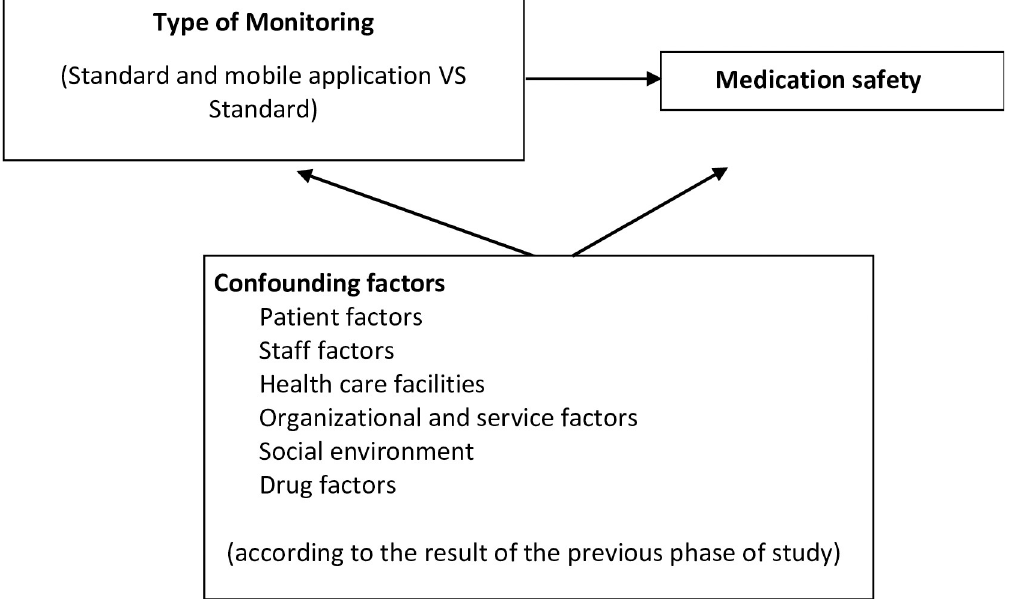
Fig 2. Conceptual framework (4th phase of the